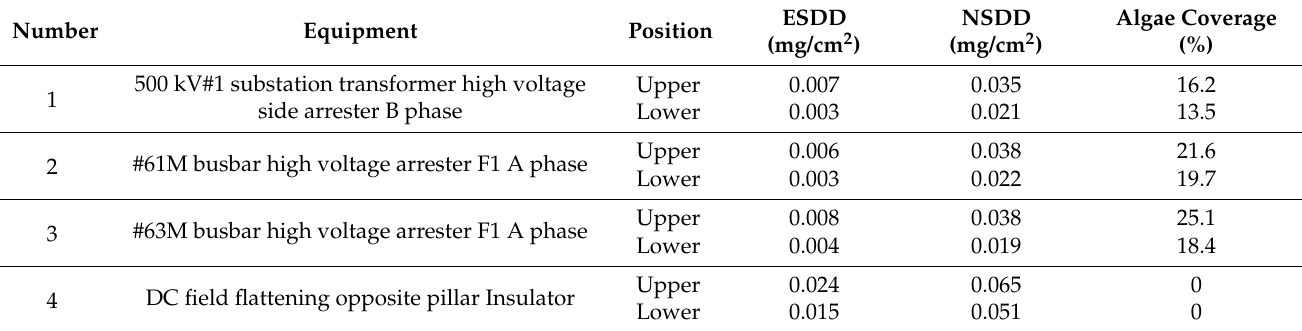
Table 4. The contamination test and algae attachment on the DYS converter station in 2018.